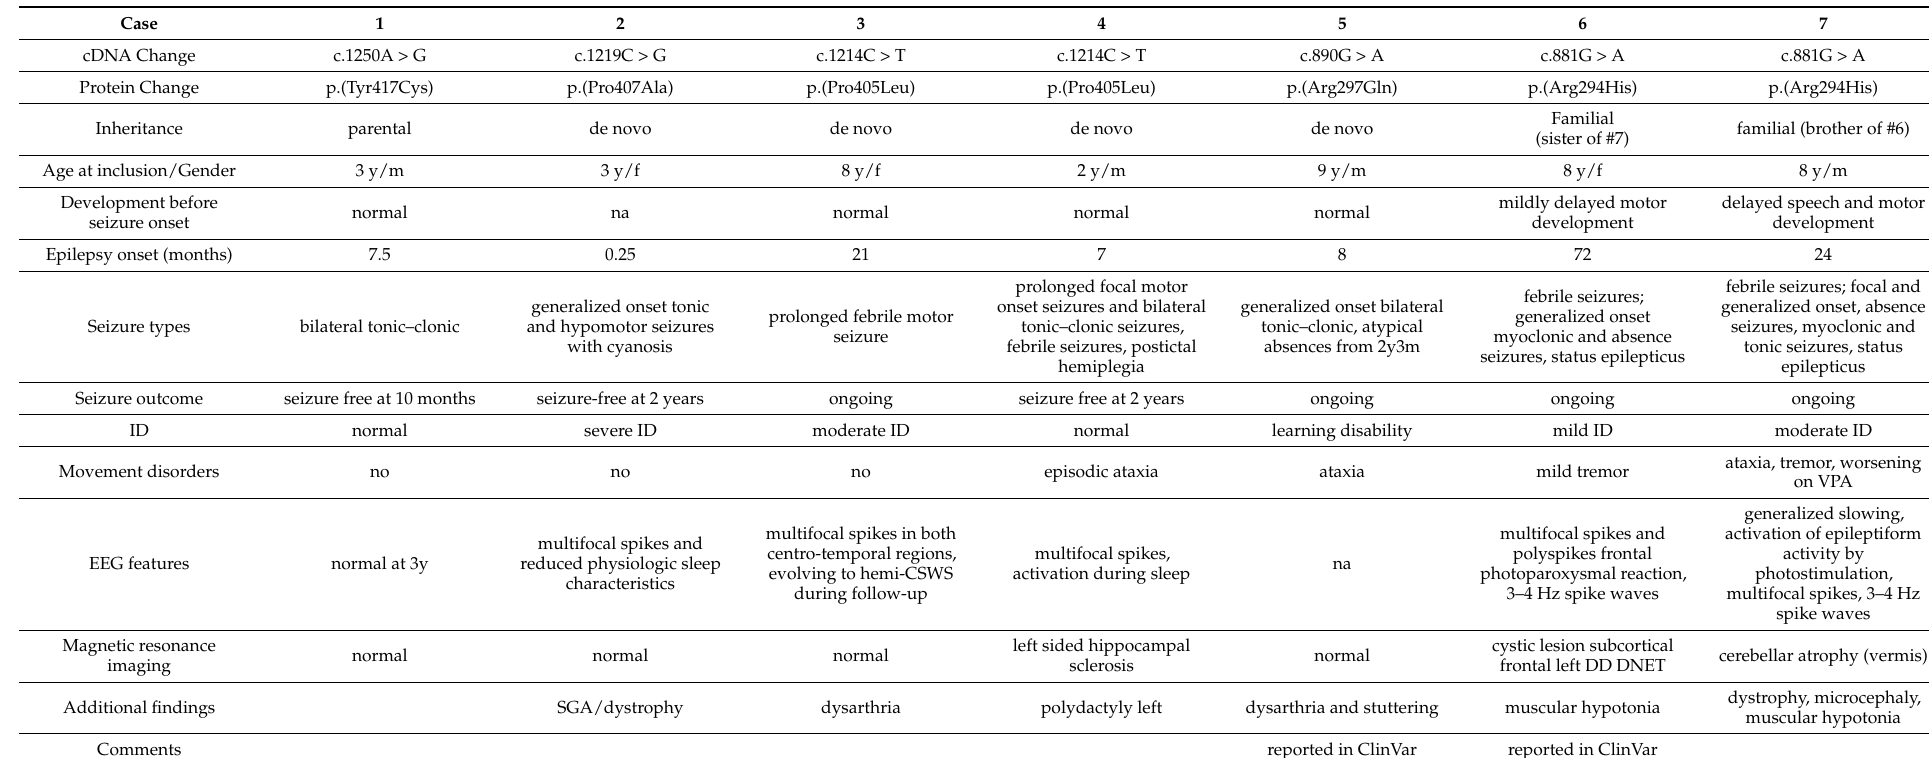
Table 3. Genetic and clinical characteristics of novel cases with KCNA2